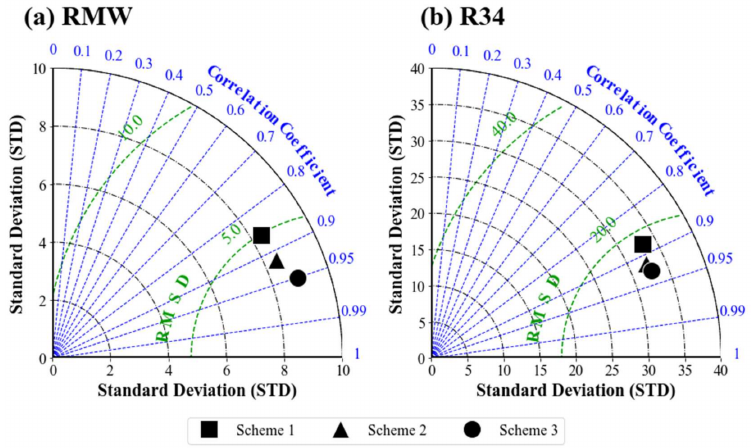
Figure 9. Taylor diagrams for ( a ) the RMW and ( b ) the R34 comparing the results of the three schemes.